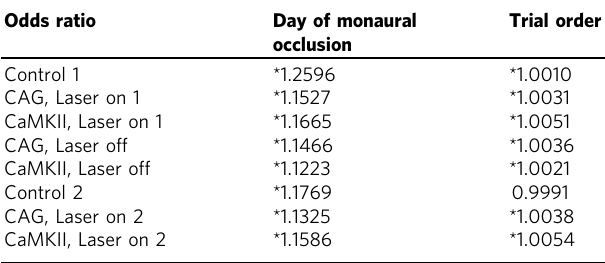
Table 2 Odds ratios for between-session and within-session trial order Odds ratio Day of monaural occlusion